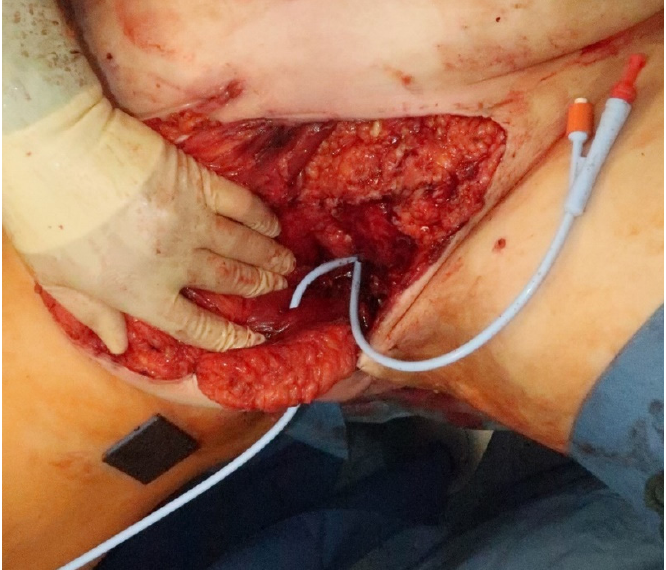
Figure 4. The VRAM flap was tunneled subcutaneously in an extrapelvic route to be placed into the perineal defect. A urinary catheter was tunneled through the middle of the VRAM flap and into the bladder through the remaining urethra. The old urinary catheter is still in place.